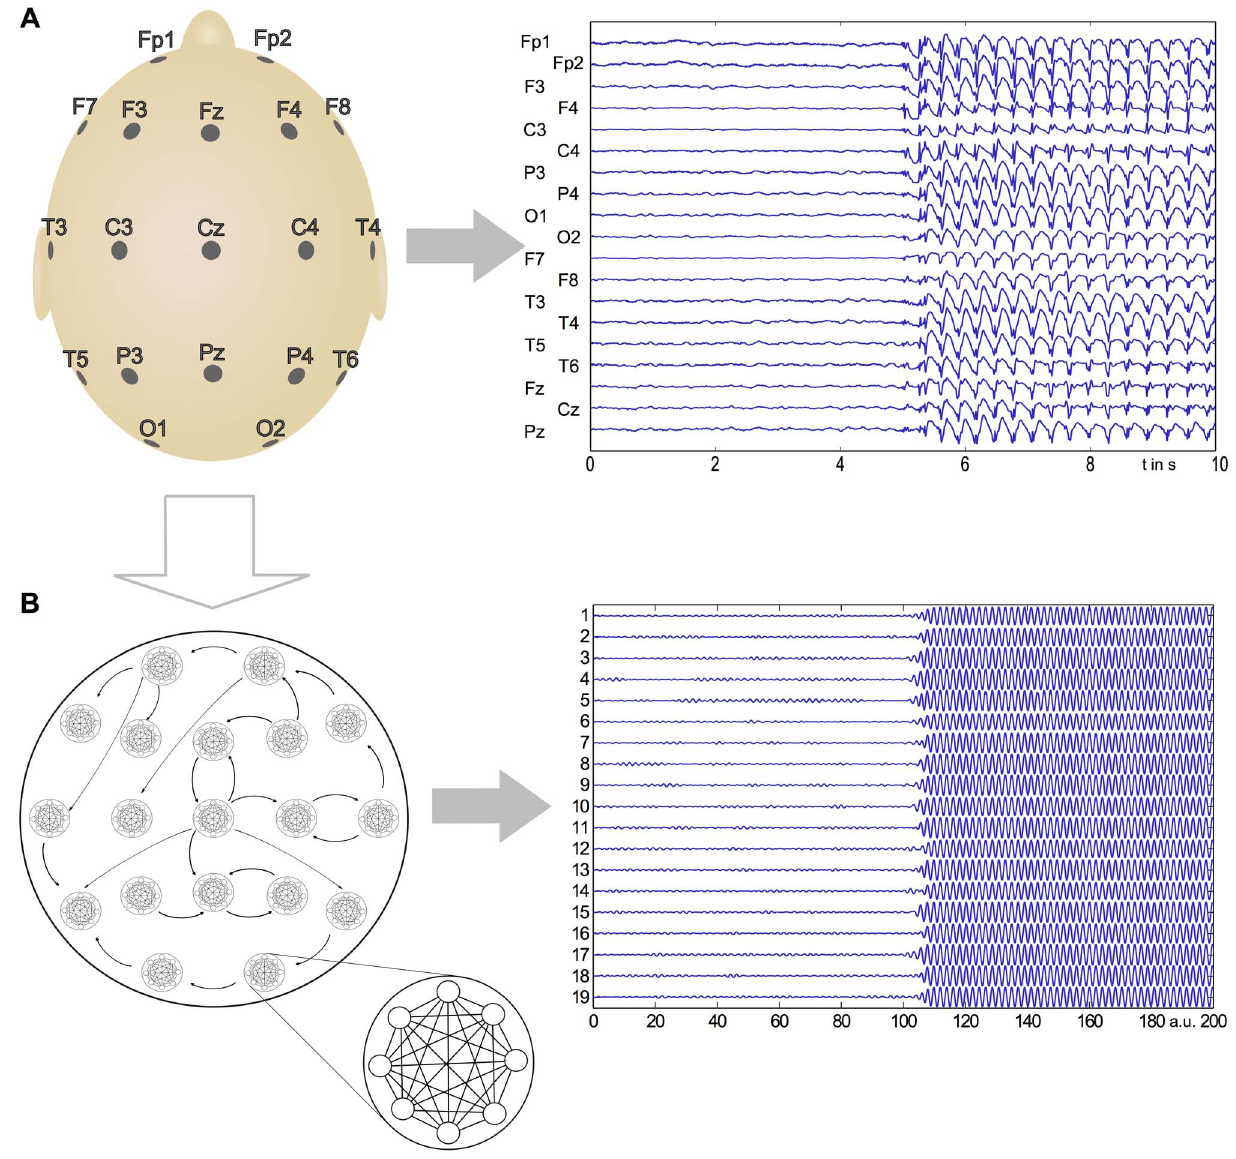
Figure 2. Comparison of recorded seizure with model output. Here we present a comparison between the clinically recorded onset of a generalized seizure event and the output of the modular Kuramoto network, demonstrating that critical features of this transition are captured by the phenomenological model. A : Epileptic seizure as captured by EEG. B : The Kuramoto model displays behavior similar to epileptic seizures. In the model, we assume local networks (where a node represents a recording site) to be all-to-all connected, analogous to a collection of cortical columns. These nodes are then directionally connected, resulting in a modular network with two scales of coupling.